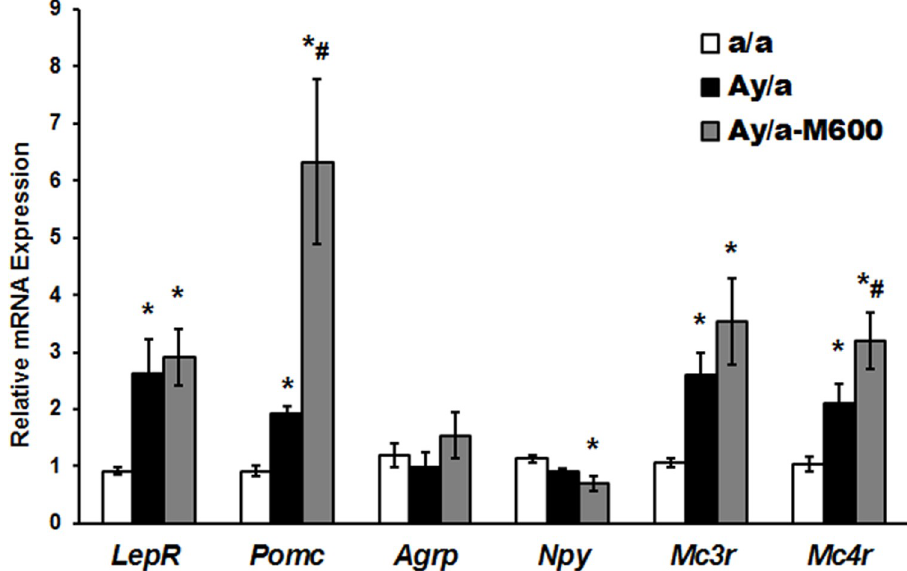
Fig 7. The expression of the genes in the hypothalamus of obese agouti-mice and the effect of metformin treatment. The levels of mRNA expression of the Lepr , Pomc , Agrp , Npy , Mc3r and Mc4r genes encoding LepR, POMC, AgRP, NPY, MC 3 R and MC 4 R are normalized by the expression of the reference 18s rRNA and Hprt genes. The relative mRNA expression is calculated with the respect to control group. The data are presented as the M ± SEM , n = 5. � —the difference between the Groups a/a and Ay/a-M600 is significant at the P < 0.05, #—the difference between the Groups Ay/a and Ay/a-M600 is significant at the P < 0.05.